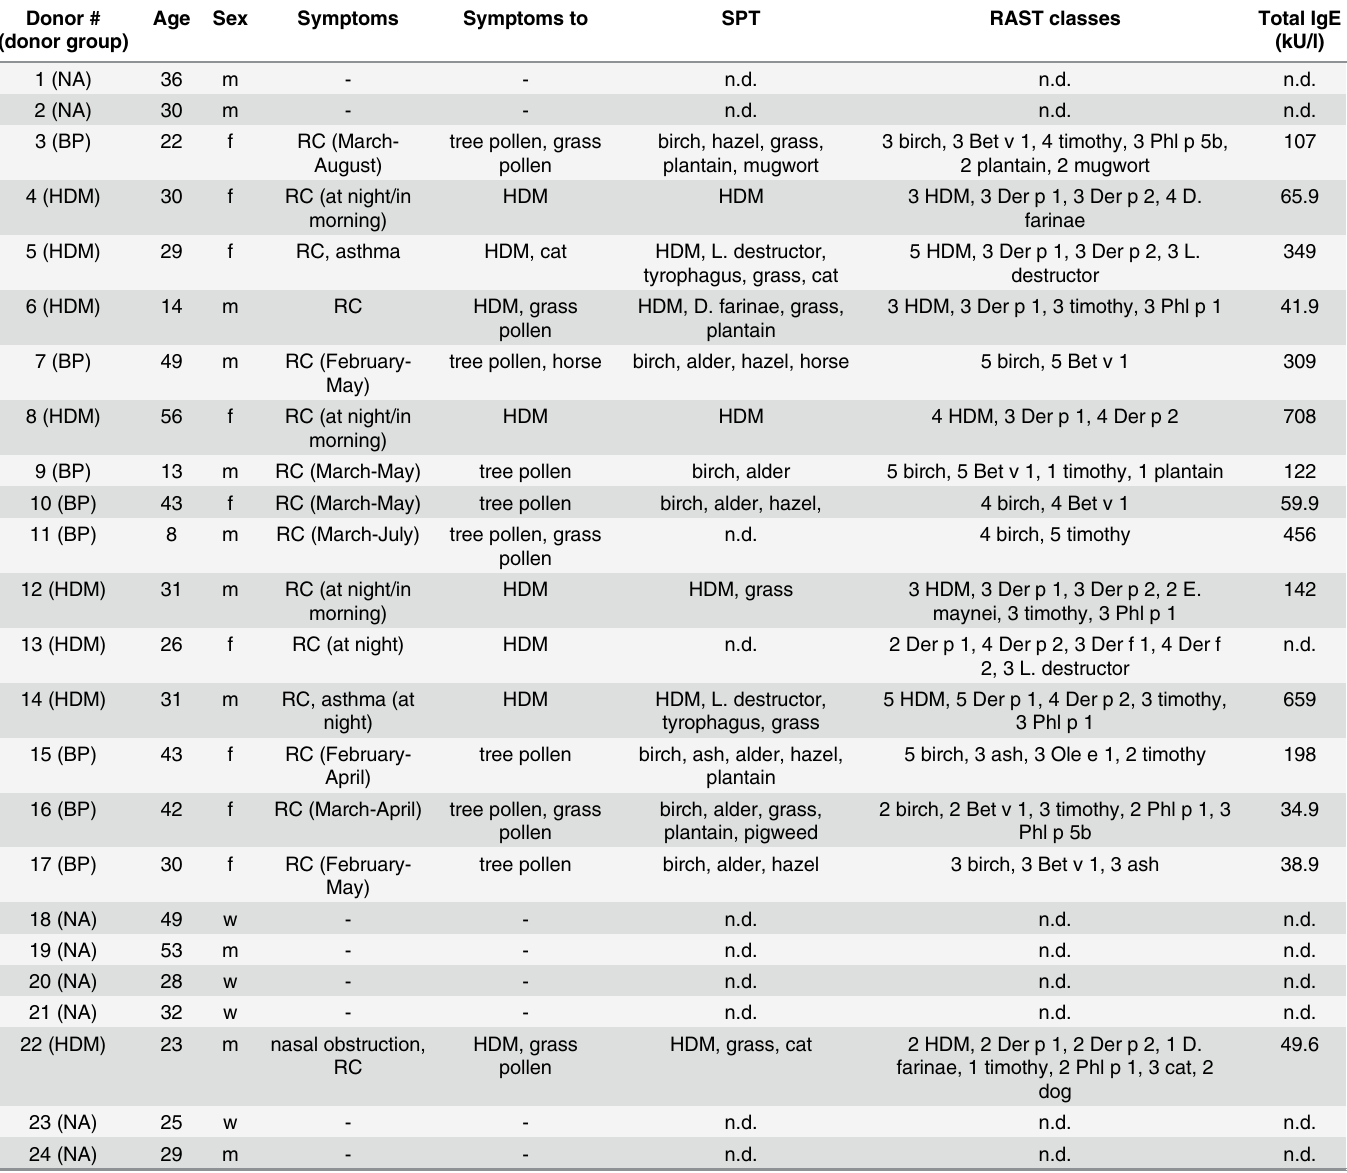
Table 1. Allergic patients and non-allergic